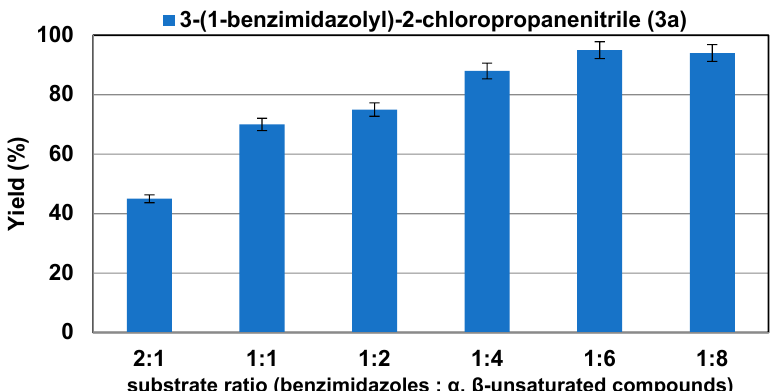
Figure 2. The influence of substrate ratio (benzimidazoles: α , β -unsaturated compounds) on the synthesis of N-substituted benzimidazole derivatives catalyzed by lipase TL IM from Thermomyces lanuginosus in continuous-flow microreactors.